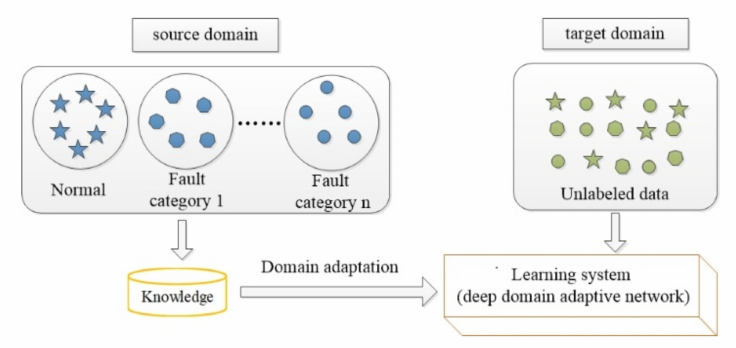
Figure 1. The learning process of domain